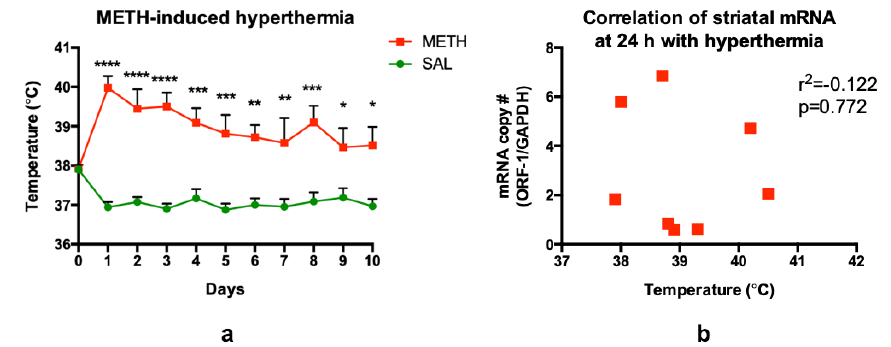
Figure 7. ( a ) Chronic METH administration (20 mg / kg / d, for 10 d, i.p.) induces significant core body temperature elevations, lasting throughout the treatment (10 d). ( b ) ORF-1 mRNA levels measured 24 h after METH treatment did not correlate with METH-induced hyperthermia. Abbreviations: METH, methamphetamine; SAL, saline. * p < 0.05, ** p < 0.01, *** p < 0.001, **** p < 0.0001, METH vs. SAL.